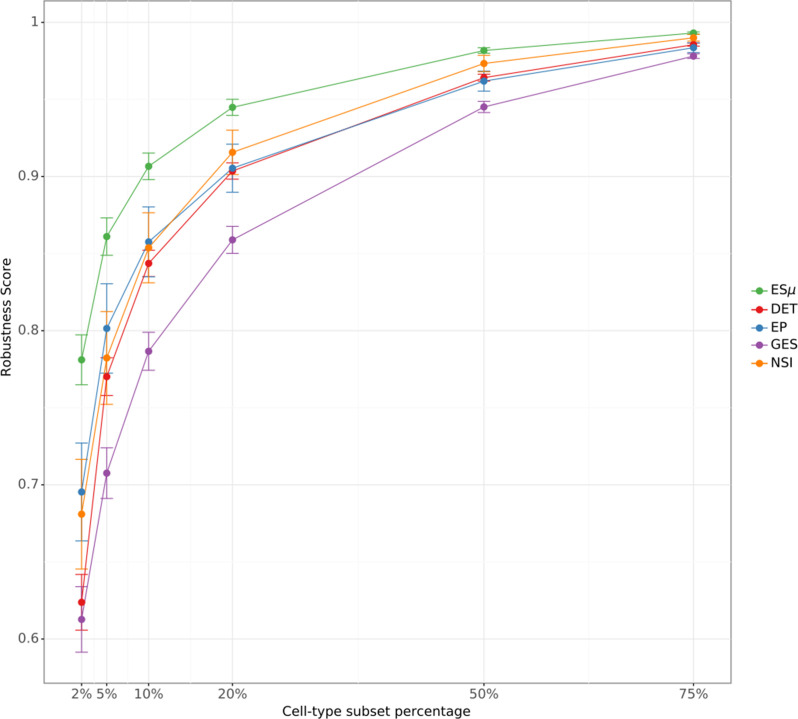
Robustness of ES metrics.The figure depicts the robustness score (RS) for each ES metric as a function of cell type subset percentage. Each point represents the mean RS across 12 focal cell types. Error bars indicate standard error of the mean.